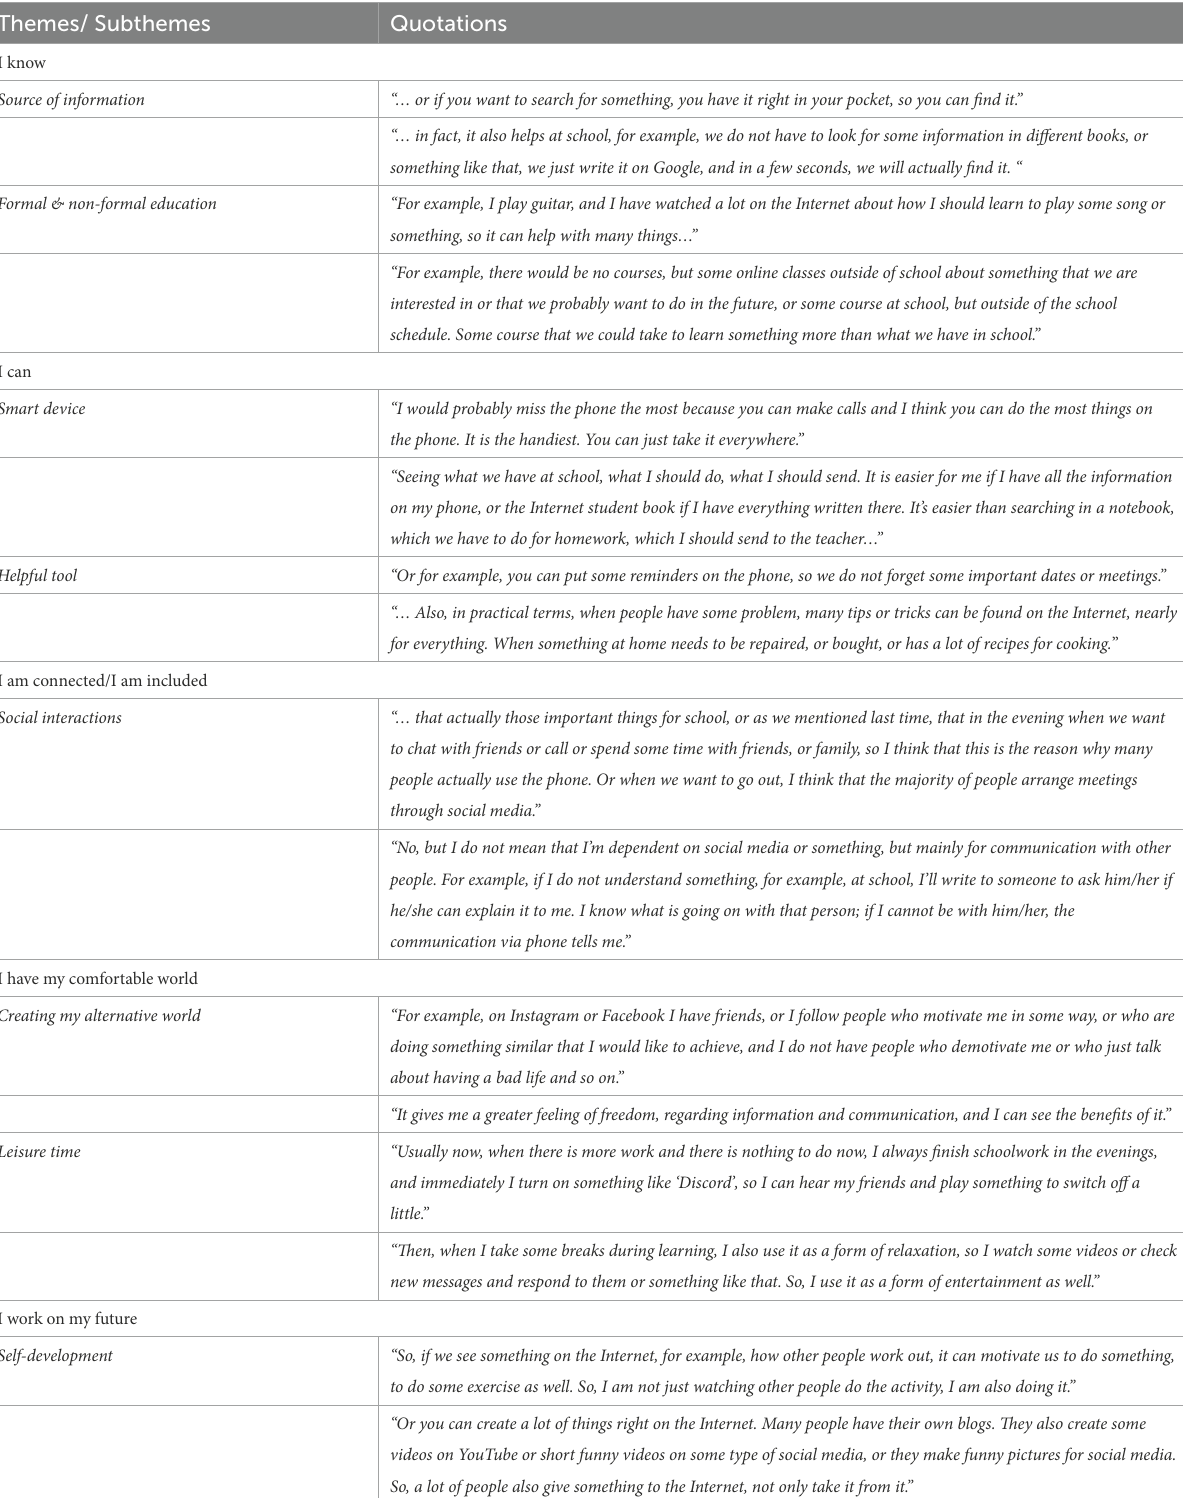
TABLE 2 Selected participant quotations for identified themes and subthemes on the benefits of digital technology for adolescents. Themes/